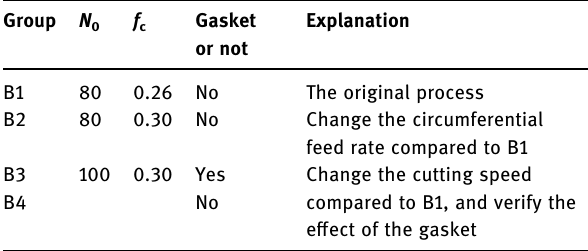
Table 6: The design scheme of the optimization